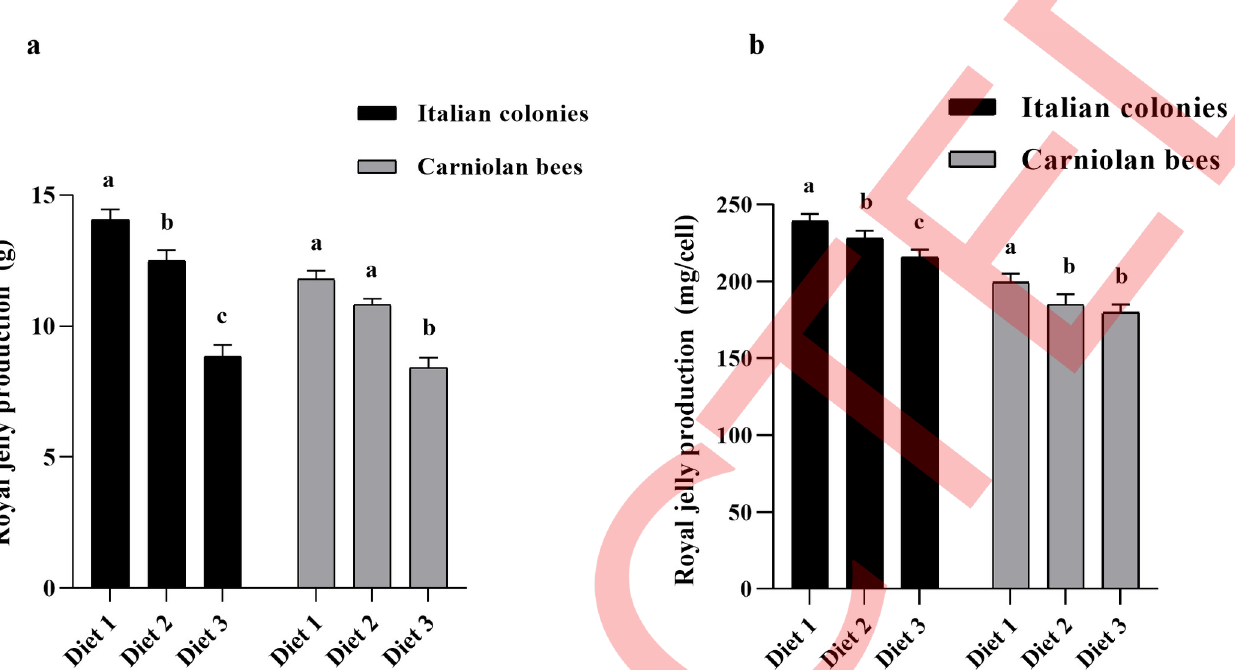
Fig 6. The effect of various diets [Diet 1 = pollen from a natural source; Diet 2 = pollen substitutes (soybean flour + brewer’s yeast powder); Diet 3 = sugar syrup (1:1 with water)] on royal jelly (mean ± SE) production in Italian and Carniolan colonies. (a) RJ production per colonies in grams after 72 hours of harvesting, (b) RJ production per cell cup in (mg) between both bee stocks. “ a, b, c ” different letter represents significant mean differences (Student’s t -test, p < 0.05).